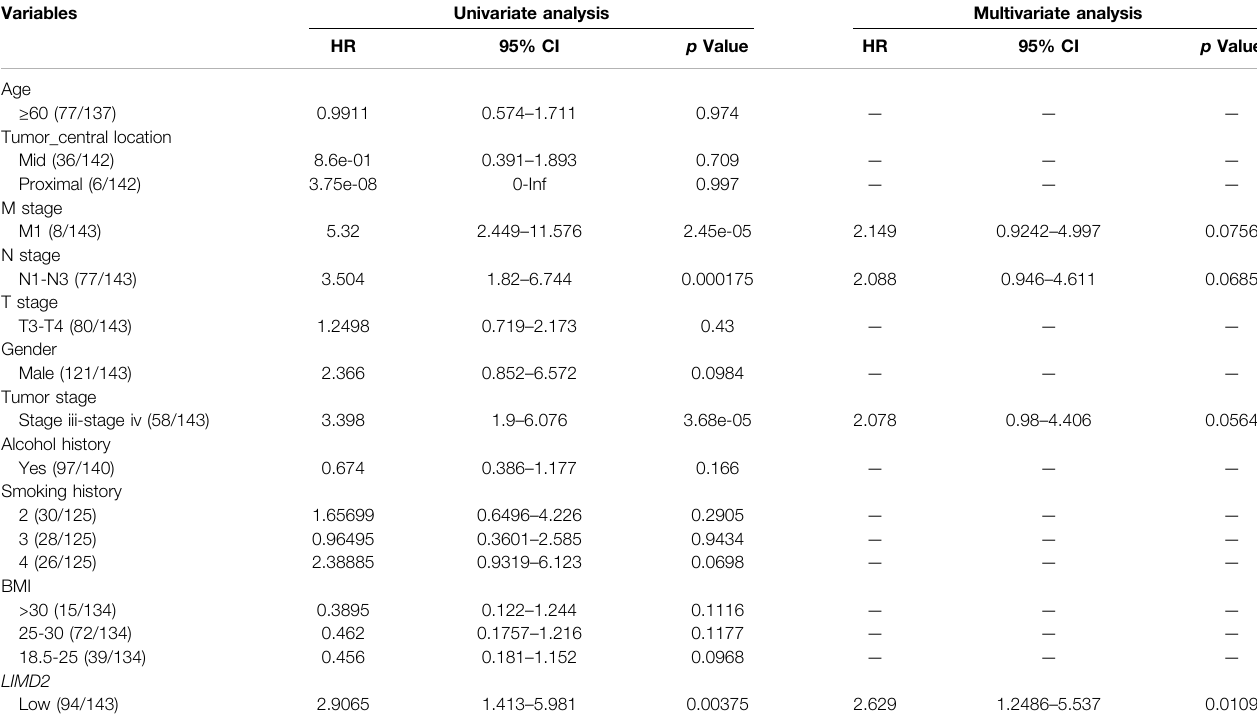
TABLE 1 | Results of univariate analysis and multivariate analysis showing prognostic factors for OS. Variables